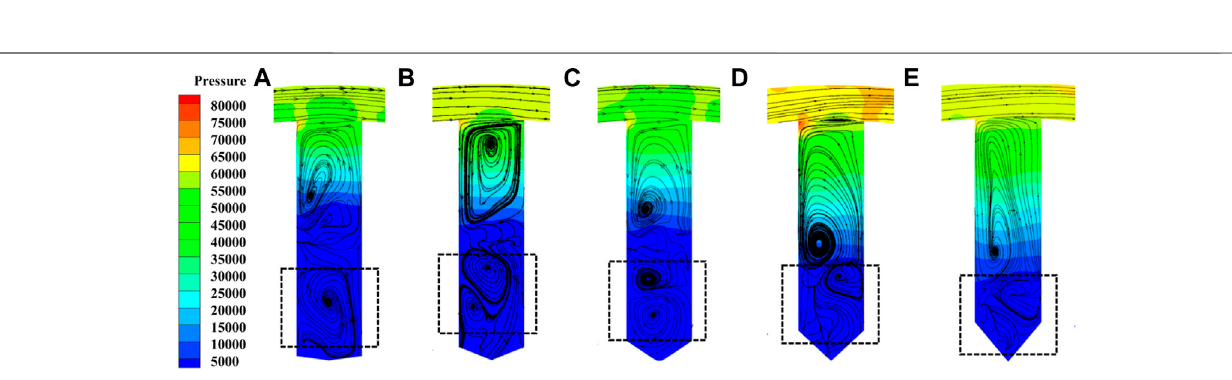
different cone bottom lengths, and the reason may be that the shear force, the centrifugal force and pressure gradient interact in the hole. Therefore, the cone bottom length mainly